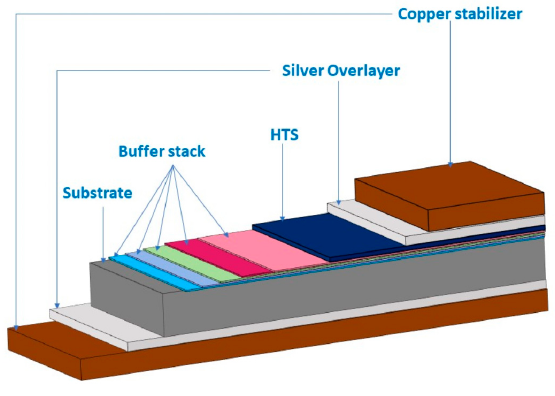
Figure 2. Configuration of SCs tape.